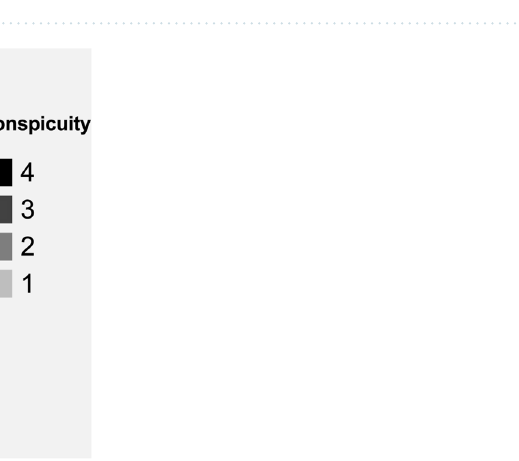
Figure 2. Graphical illustration of the quantitative impact of block sequential regularized expectation maximization (BSREM) reconstruction on pulmonary nodule SUV max with nodules stratified by size (left) and activity (right) in ordered subset expectation maximization (OSEM). In size-based analysis, the nodule with the smallest diameter is in the top row, and the largest nodule is in the lowest row . In the activtiy-based analysis, the nodule with lowest activity in OSEM is in the top row, and the nodule with the highest activity in OSEM is in the lowest row.